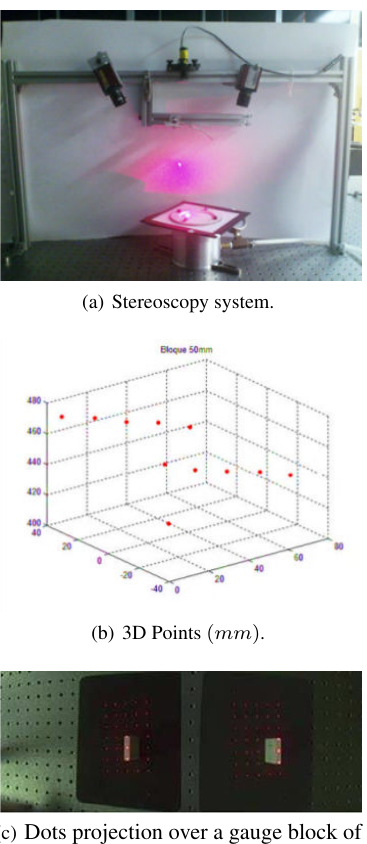
Figure 2. Passive stereoscopy setup.